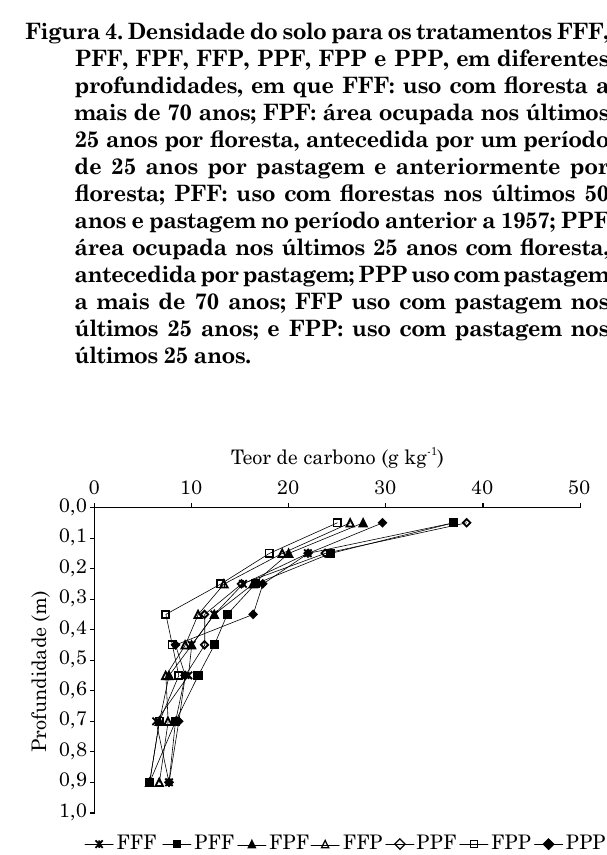
Figura 5. Teores de carbono orgânico total (COT) nos tratamentos FFF, PFF, FPF, FFP, PPF, FPP e PPP, em diferentes profundidades, em que FFF: uso com floresta a mais de 70 anos; FPF: área ocupada nos últimos 25 anos por floresta, antecedida por um período de 25 anos por pastagem e anteriormente por floresta; PFF: uso com florestas nos últimos 50 anos e pastagem no período anterior a 1957; PPF: área ocupada nos últimos 25 anos com floresta, antecedida por pastagem; PPP: uso com pastagem a mais de 70 anos; FFP: uso com pastagem nos últimos 25 anos; e FPP: uso com pastagem nos últimos 25